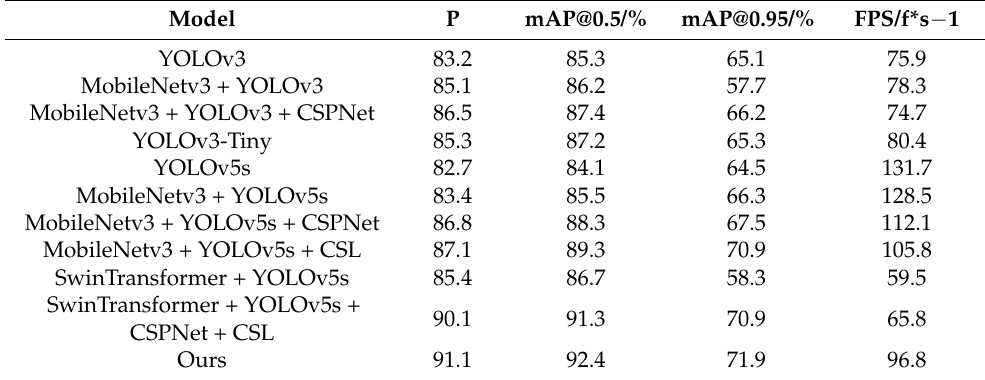
Table 4. Performance comparison of different